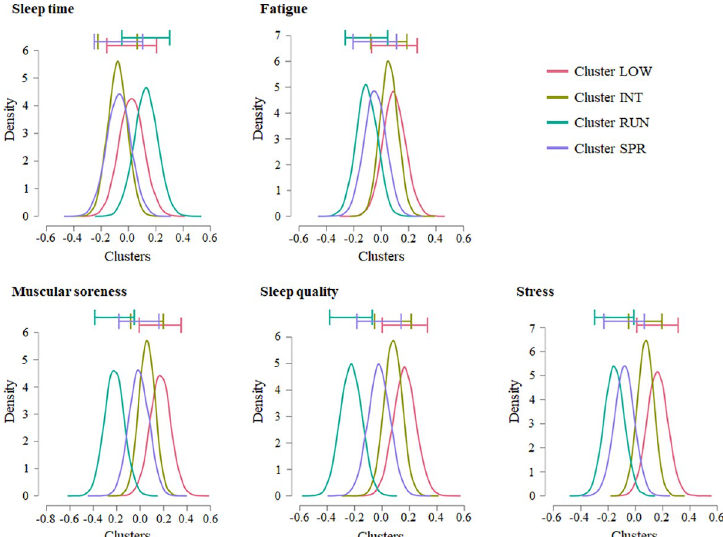
Fig 4. Model averaged posterior distributions and credible intervals of the relationship between the clusters and the wellbeing and recovery variables. LOW = lower-demand sessions; INT = intermediate-demand sessions; RUN = running-based sessions; SPR = sprint-based